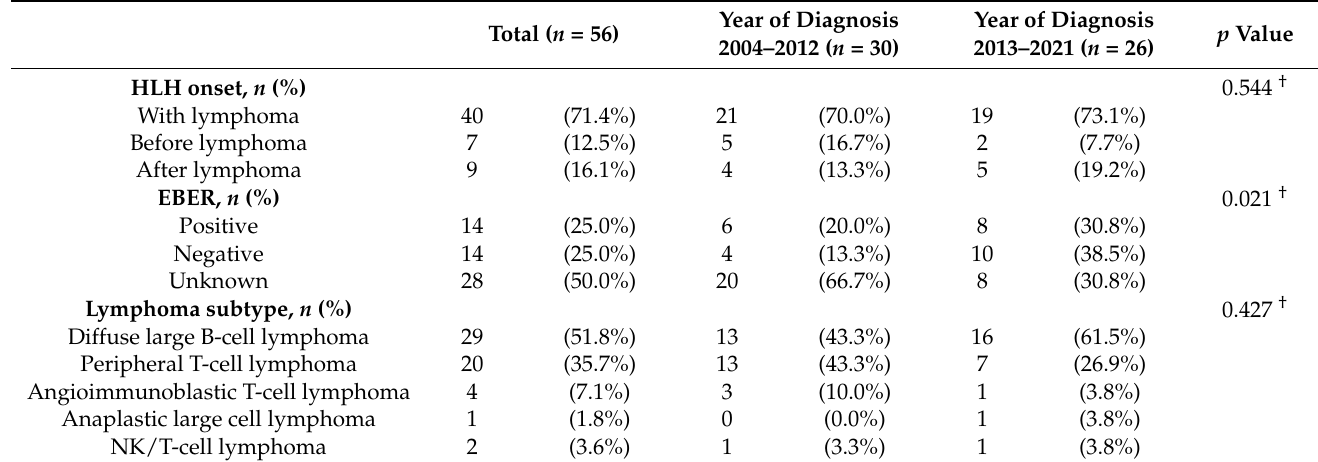
Anaplastic large cell lymphoma